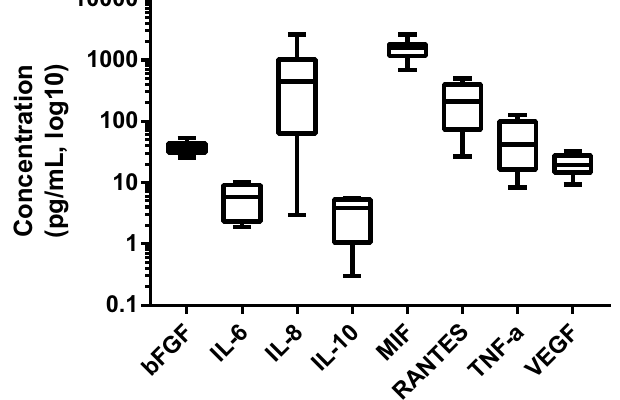
Figure 3. Cytokines in RBC conditioned media. Concentration of cytokines in the conditioned media of RBCs (400 × 10 8 cells per mL) incubated in PBS for 24 hours at 37 °C as measured by Bio-Plex. Data are presented as mean with minimum and maximum values ( n =